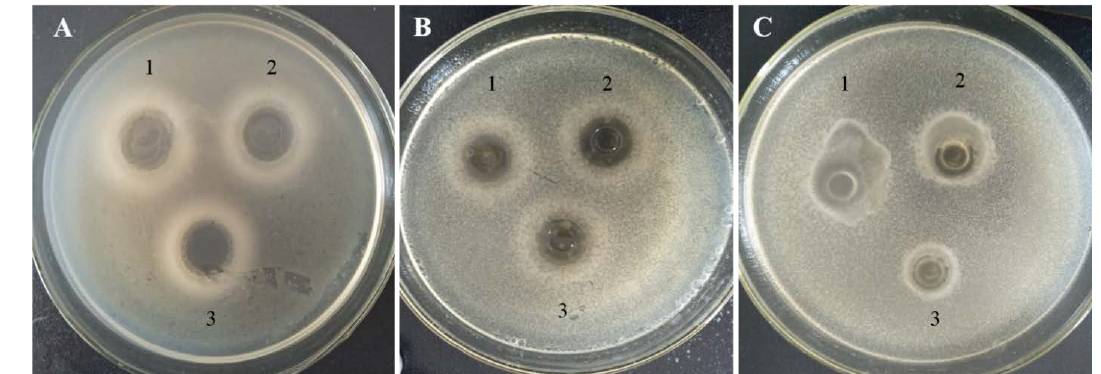
Figure 4. Antimicrobial action of in situ production of bacteriocin in bozai BZ- LF against ( A ) S. aureus , ( B ) E. coli k-12, and ( C ) Salmonella sp. D104. 1, 2, 3 represents as triplicate of inhibition zone ( n = 3) Based on this study, L. fermentum BZ532 can inhibit the growth of E. coli and S. aureus in the fresh bozai production system thanks to its bacteriocinogenic ability during storage; however, it was not able to counter the activity of Salmonella sp. in fresh bozai. Further